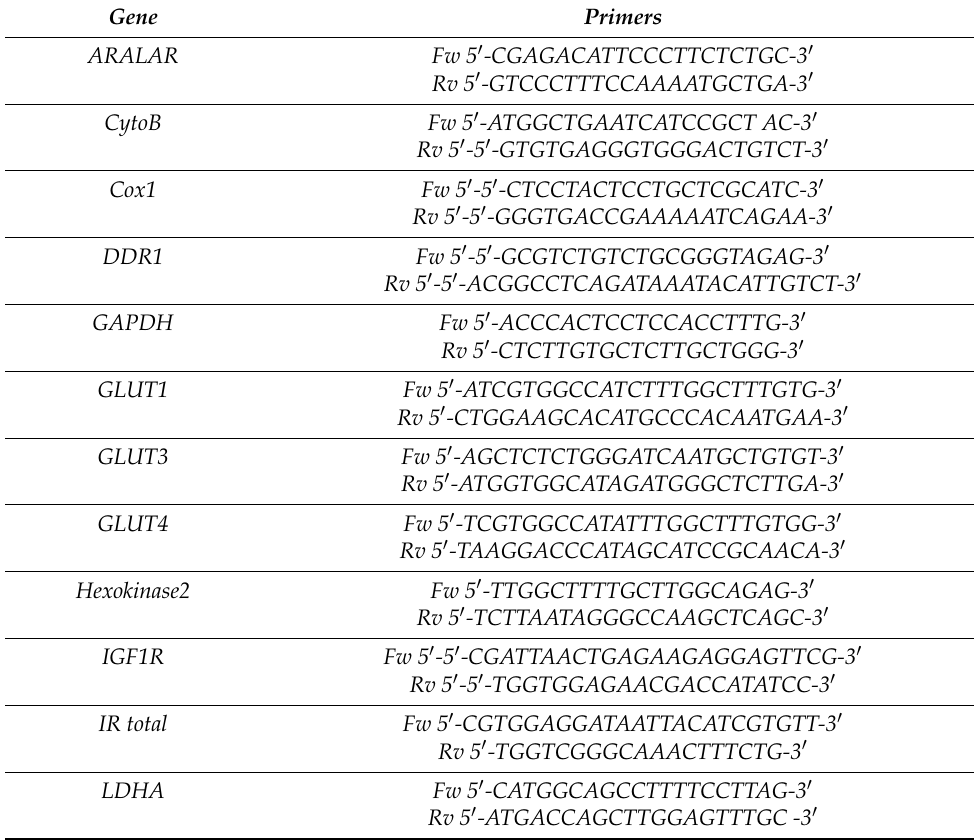
Table 1. PRC primers